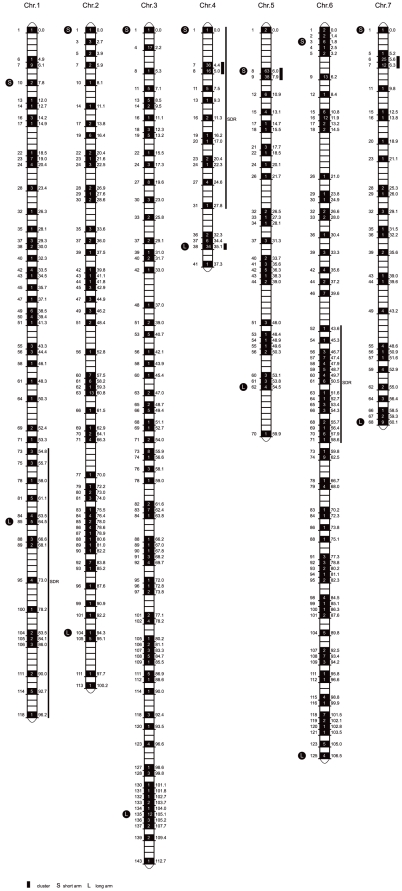
Cucumber linkage map developed from the present study.The Bin names and genetic distances in cM are respectively listed on the left and right of the chromosomes. The number of SSR markers in each filled Bin is indicated in the boxes. White boxes indicated a recombination event with no markers. The short and long arms are indicated with S and L, respectively SDR = segregation distortion region.